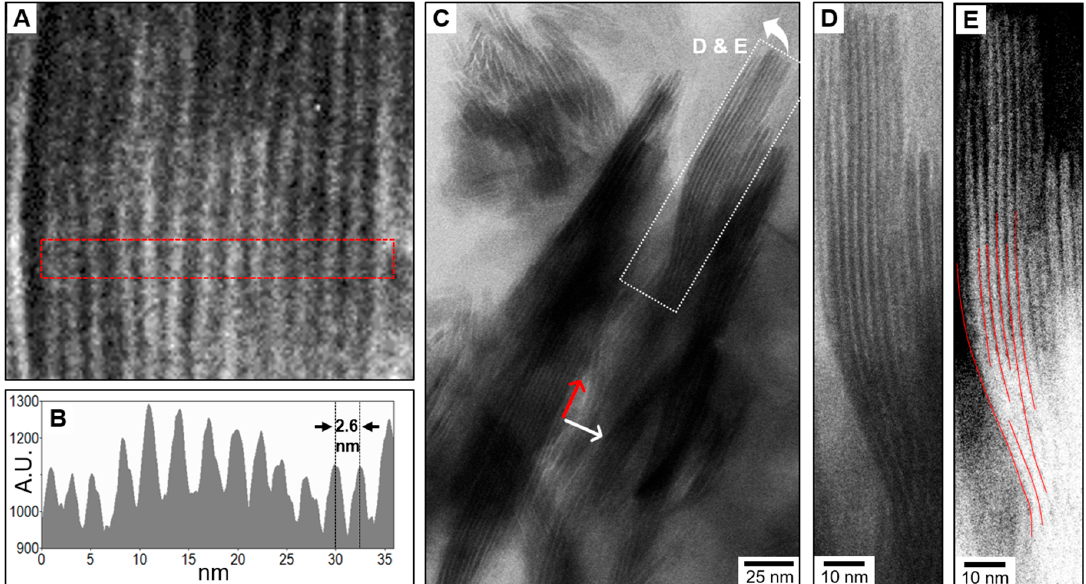
Figure 4. Self-organized aggregates of bone-like hydroxyapatite particles in water. ( A , C , D , E ) Cryogenic transmission electron micrographs (cryo-TEM) of the organized and oriented structures that the synthetic Carbonated HydroxyApatite (CHA) platelet-shaped particles form spontaneously in water. Shown in ( A ) is a self-organized aggregate in which the CHA platelets (seen edge-on) are regularly stacked side-by-side perpendicular to their elongated direction; displayed in ( B ) is its corresponding contrast intensity profile integrated over the rectangle region marked by the red dashed-line drawn in ( A ). Shown in ( C ) are self-organized aggregates in which numerous CHA platelets (seen edge-on) are not only aligned with each other but are also arranged side-by-side, respectively parallel (red arrow) and perpendicular (white arrow) to their elongated direction. ( D ) shows a magnification of the rectangle region marked by the white dashed-line drawn in ( C ), while ( E ) is a micrograph corresponding to the same region in which the colors, the contrast, and the brightness have been respectively inverted, enhanced, and lowered. The narrow gaps in between platelets appear here in black and are more visible; some of them have been covered by red lines to demonstrate the presence of gentle curvatures along the elongated direction of the platelets.